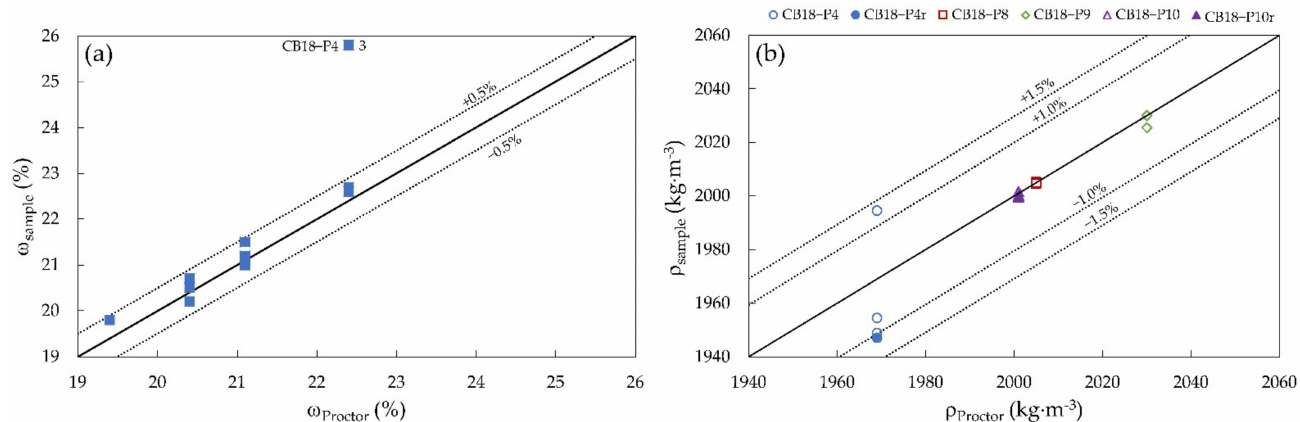
Figure 15. Direct Shear samples compared to the standard Proctor samples. ( a ) Moisture content of the Direct Shear samples ( ω sample ) versus the target moisture content ( ω Proctor ); ( b ) Apparent density of the Direct Shear samples ( ρ sample ) versus the target density ( ρ Proctor